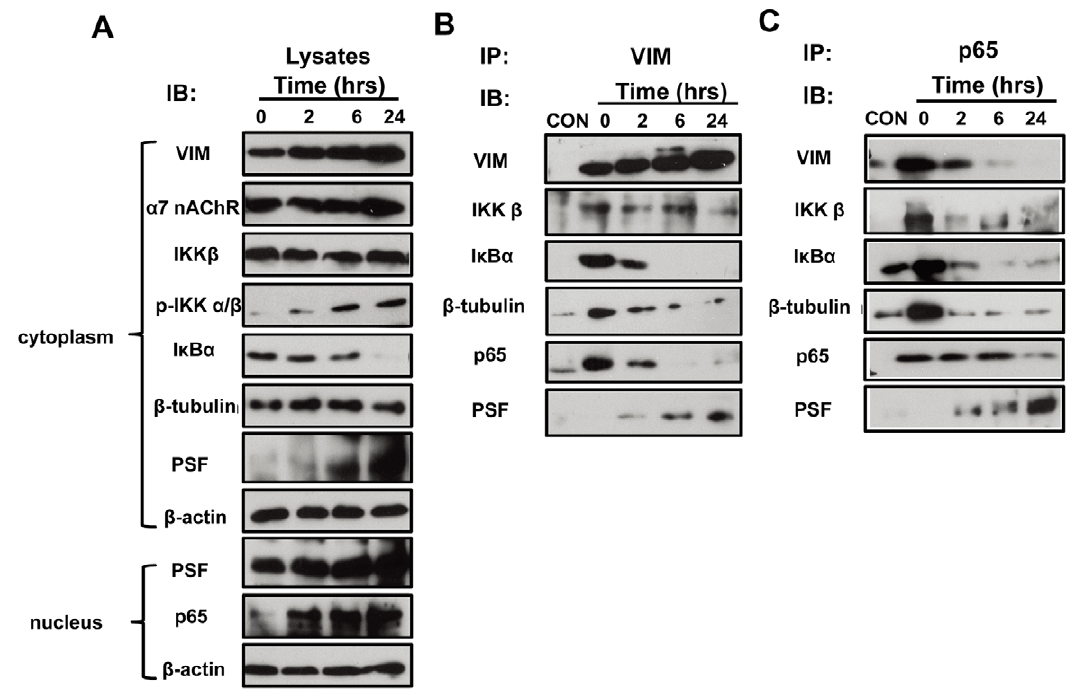
Figure 4. Time course analysis of IbeA-induced cytoplasmic activation and nuclear translocation of NF- k B. HBMECs ware incubated with the IbeA protein (0.1 m g/ml) for 2, 6, and 24 h, respectively, and then the cytoplasmic and nuclear fractions were extracted. The cytoplasmic fractions were immunoprecipitated (IP) with the V9 anti-vimentin antibody and the rabbit anti-NF- k B (P65) antibody as described in Materials and Methods. The cytoplasmic and nuclear lysates ( A ), vimentin Co-IP complexes ( B ), and NF- k B (p65) Co-IP complexes ( C ) were subjected to western blot using the antibodies as described in Materials and Methods. CON: the IP control without primary antibodies incubation; 0 h: the control HBMECs without IbeA stimulation.